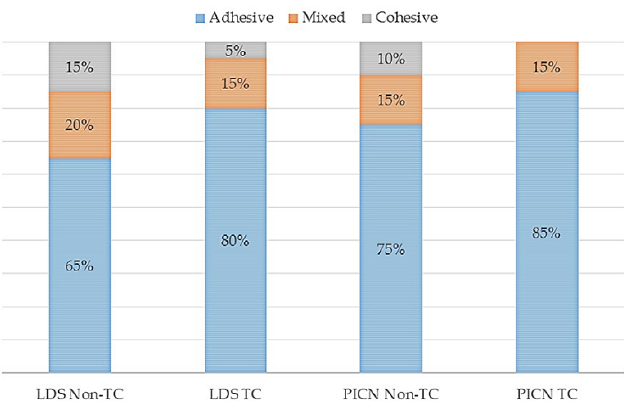
Figure 6. Failure modes of each group after microshear bond-strength test.